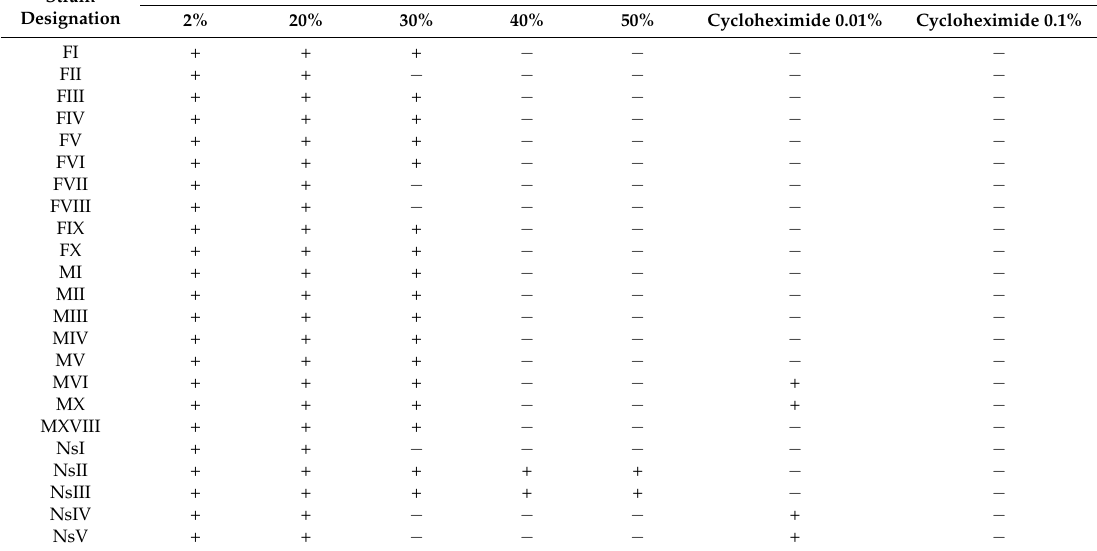
Table 5. Osmotolerance and cycloheximide resistance of the veil-forming yeasts used in this study and analyzed by microtiter technology. Values are expressed as (+) if yeast strains were able to growth in a particular concentration of glucose/fructose solution and ( − ) if yeast strains were not able to growth. Strain